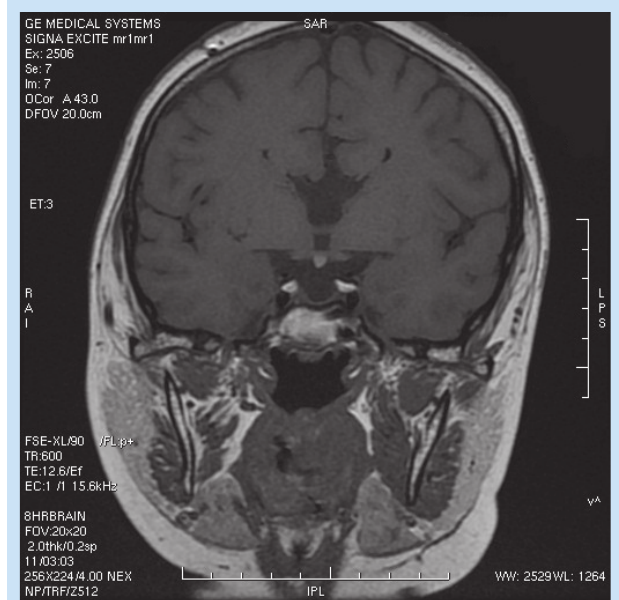
Fig. 2. A sagittal T1W MRI scan demonstrating the hyperintense poste- rior pituitary gland outside the sella, and adjacent to the optic chiasm. The pituitary stalk is not visualised. The adenohypophsis is hypoplastic. Note the small cyst in the pineal gland.